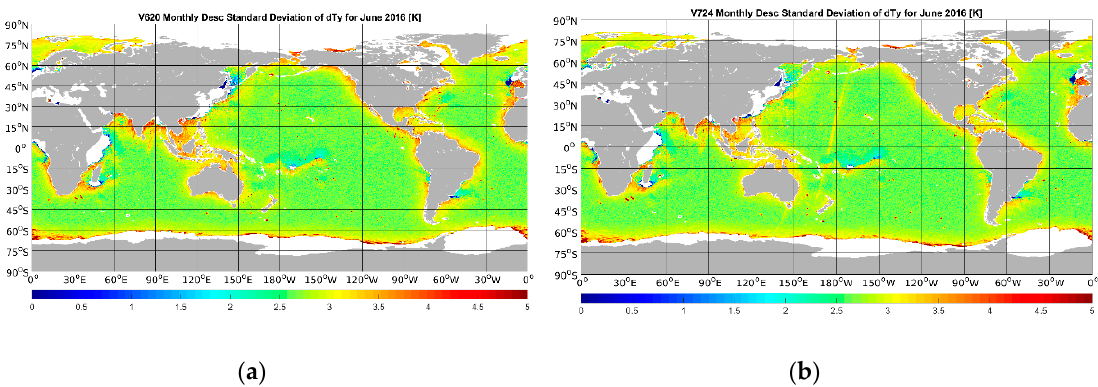
Figure 18. Standard deviation of the SMOS measurements in June 2016 for v620 ( a ) and v724 ( b ).